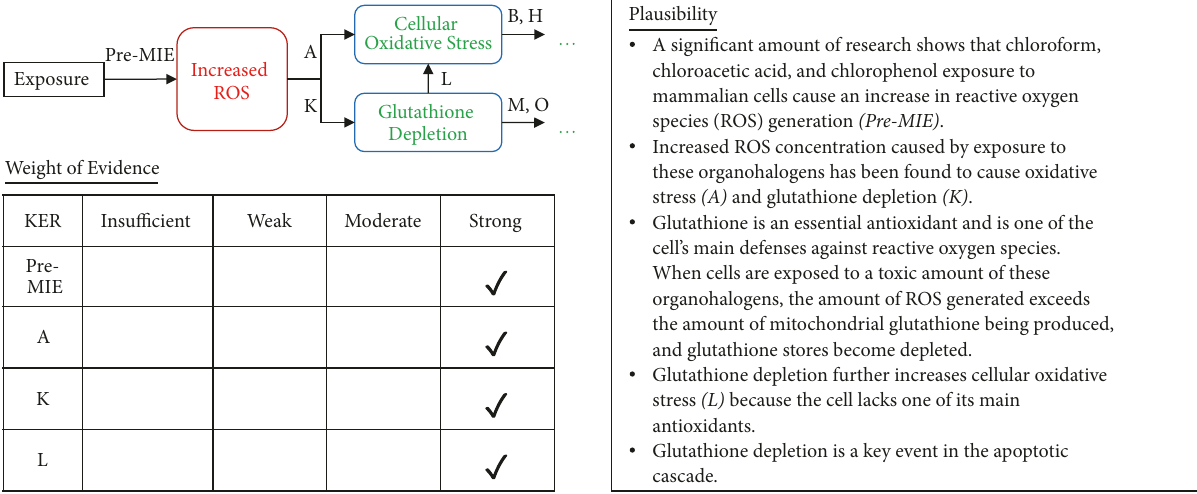
Figure 4: Exposure to MIE relationship is strong. A qualitative assessment of Key Event Relationships (KERs) in the AOP triggered by the generation of reactive oxygen species (MIE) and resulting in mitochondrial disease (AO) via KERs A, K, and L.